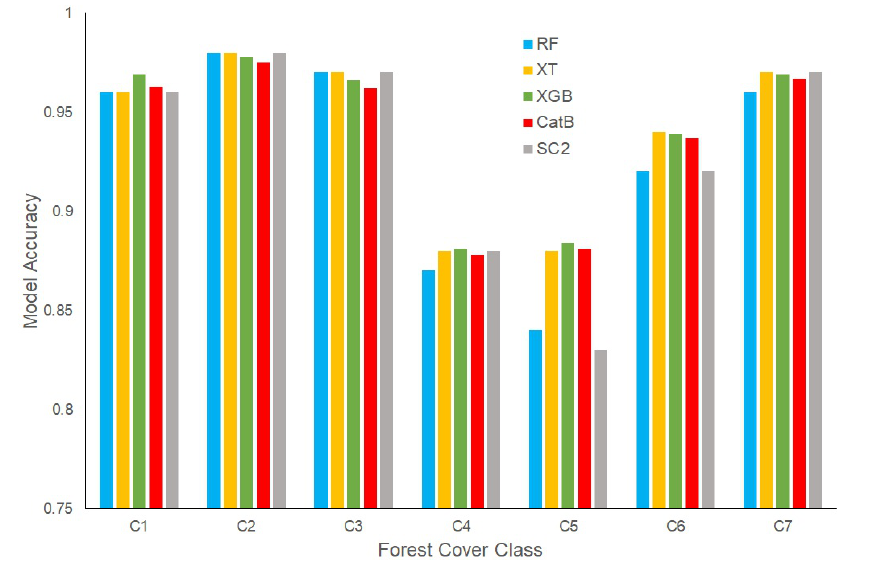
Figure 9. Accuracy of different classifiers for each cover class.